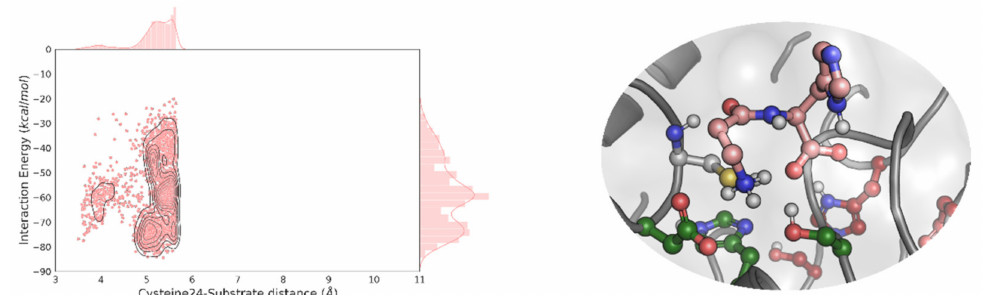
Figure 5. EH 1AB1C density plot of the distribution of the catalytic cysteine-substrate distance against the interaction energy for L-carnosine. Only the 10% lowest percentile, regarding the distance is shown. In the right panel, we display the representative catalytic poses of L-carnosine in the putative protease site. The C atoms are stained in maroon, dark green, and yellow in the EH 1A1 active site residues, EH 1B1 , and Cys24, respectively, and L-carnosine is shown using the pink colour used in the density plot. The energy profiles were created with the Matplotlib library [28].